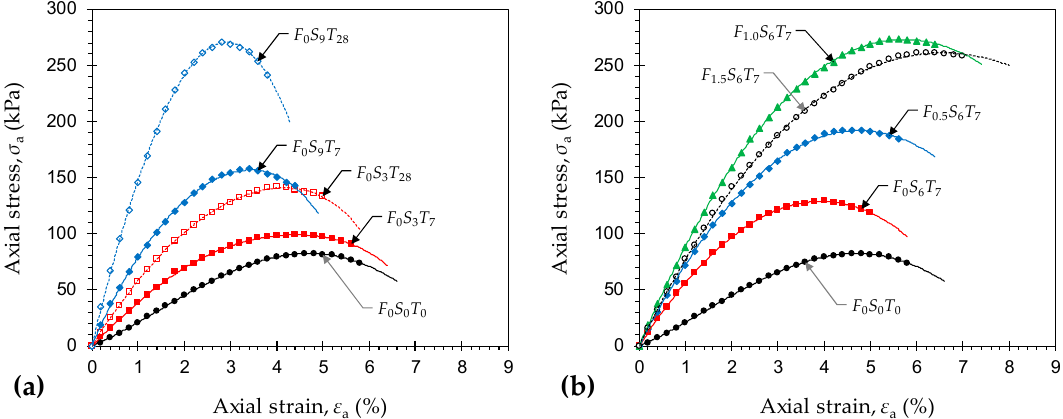
Figure 4. Typical stress–strain curves for the natural soil ( F 0 S 0 T 0 ) and various stabilized samples: ( a ) F x S y T z where x = {0}, y = {3, 9}, and z = {7, 28}; and ( b ) F x S y T z where x = {0, 0.5, 1.0, 1.5}, y = {6}, and z = {7}.